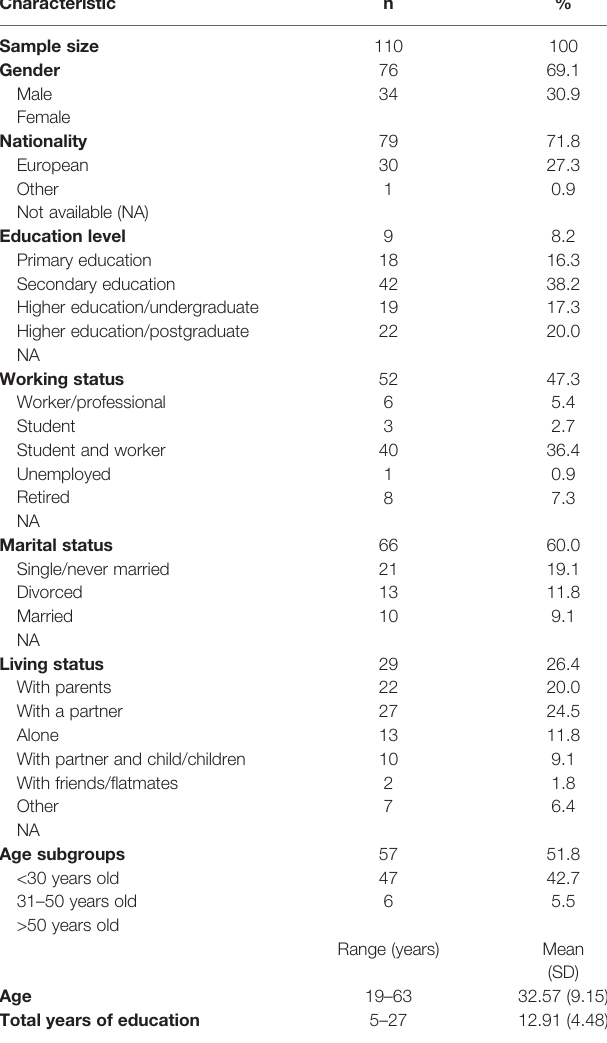
TABLE 1 | Sociodemographic characteristics of the